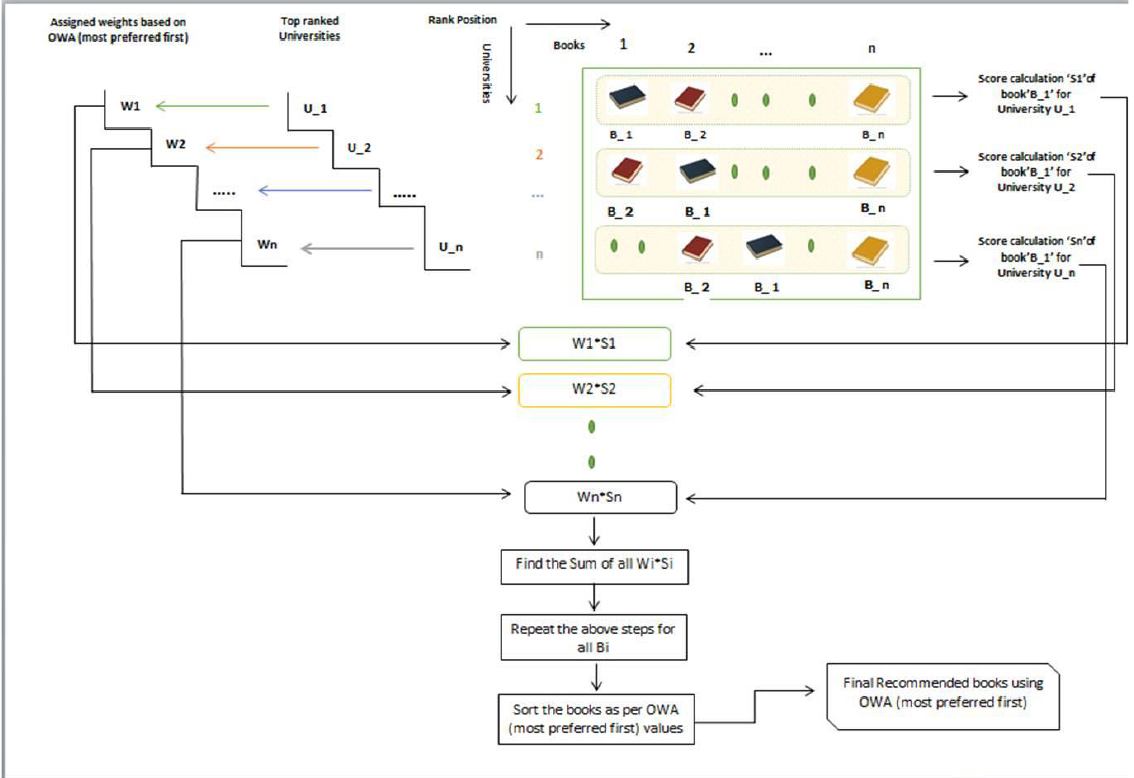
Figure 2. OWA-based approach for Book Recommendation (most preferred first). Only those courses which are kept in the curriculum by these leading institutions have been taken into consideration for the experiment. A complete list is given in Table 2. Where